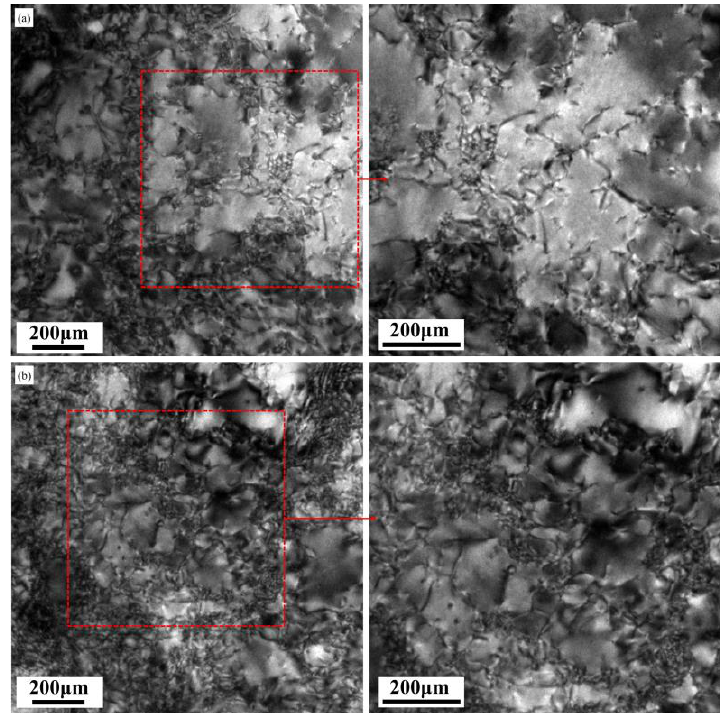
Figure 14. TEM bright-field photographs of the O-state 2195 alloys after a tensile strain of 0.12 at ( a ) 298 K, and ( b ) 77 K.